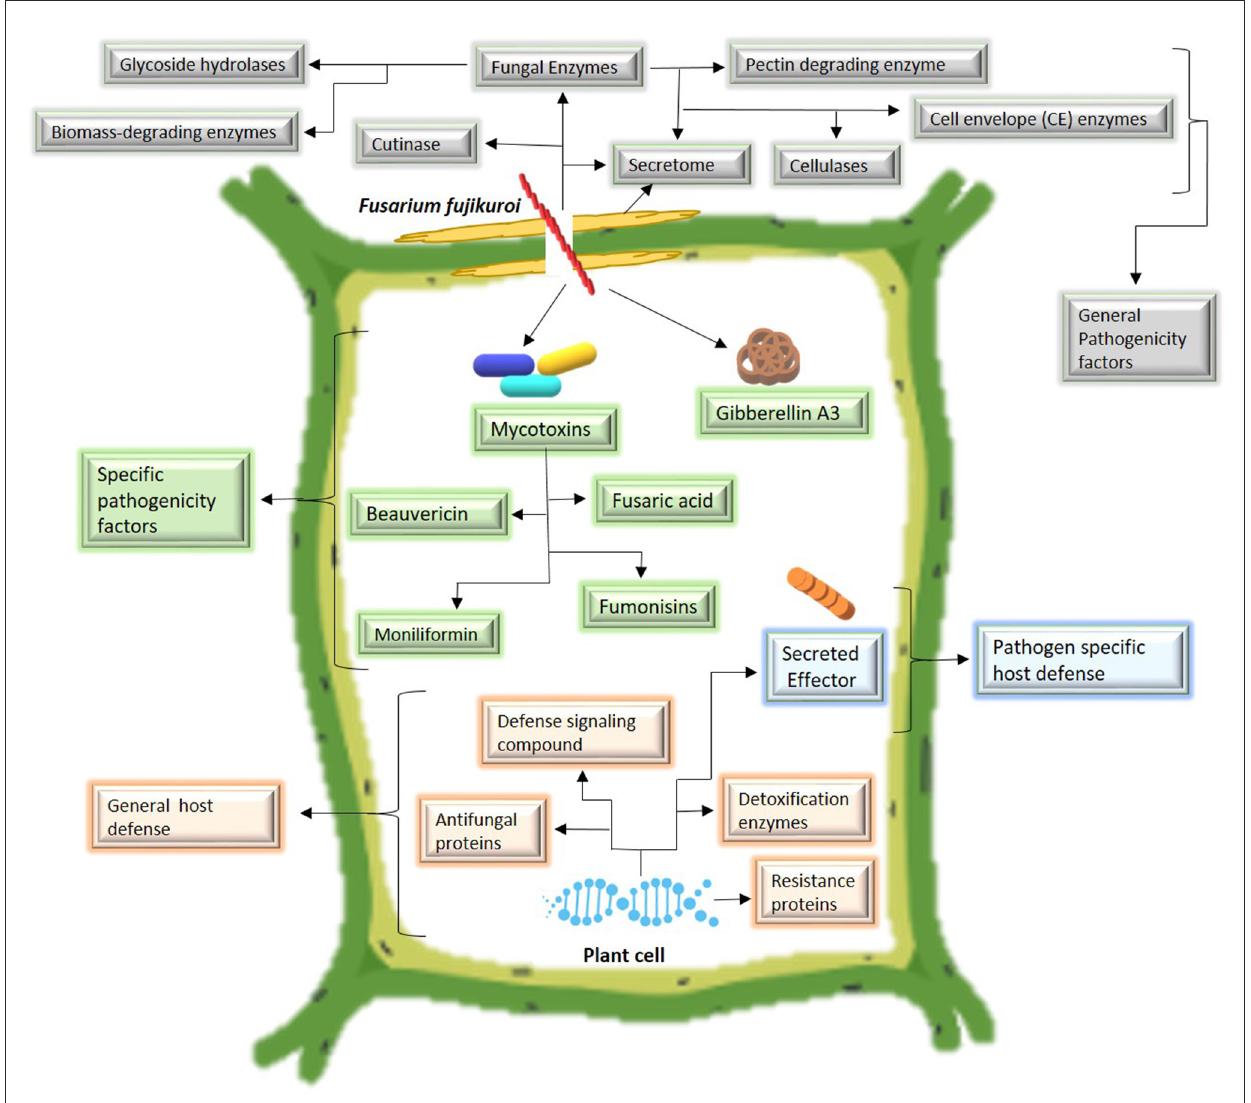
FIGURE3 Mechanism of pathogen colonization and plant host defense.